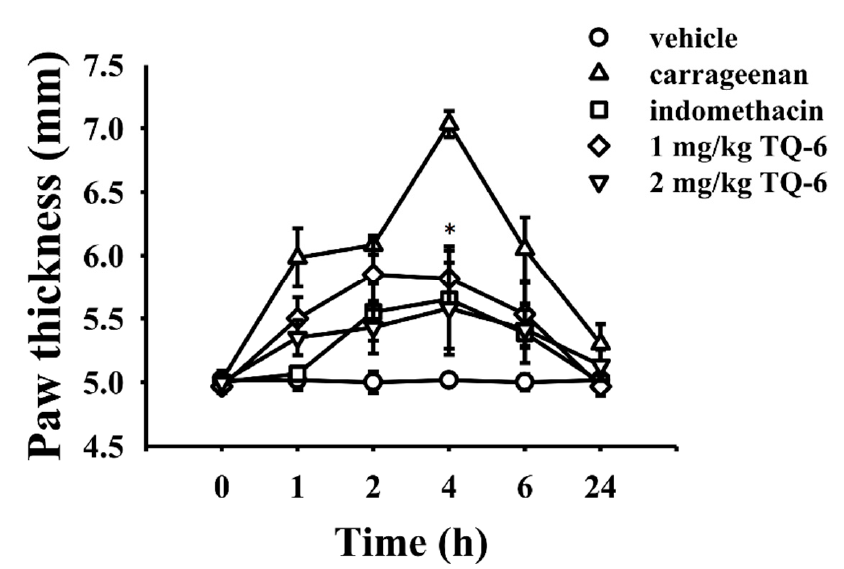
Figure 5. Effects of TQ-6 on carrageenan-induced rat paw edema. The right paw of Wistar rats was injected with TQ-6, 30 min before the carrageenan injection. The paw volume was measured before 0 h and after the intervals of 1, 2, 4, 6, and 24 h in carrageenan injection ( ○ : vehicle; △ : carrageenan; □ : 5 mg/kg indomethacin; ◇ : 1 mg/kg TQ-6; ▽ : 2 mg/kg TQ-6). Data are shown as mean ± SEM ( n = 6). * p < 0.05 compared with the carrageenan group.